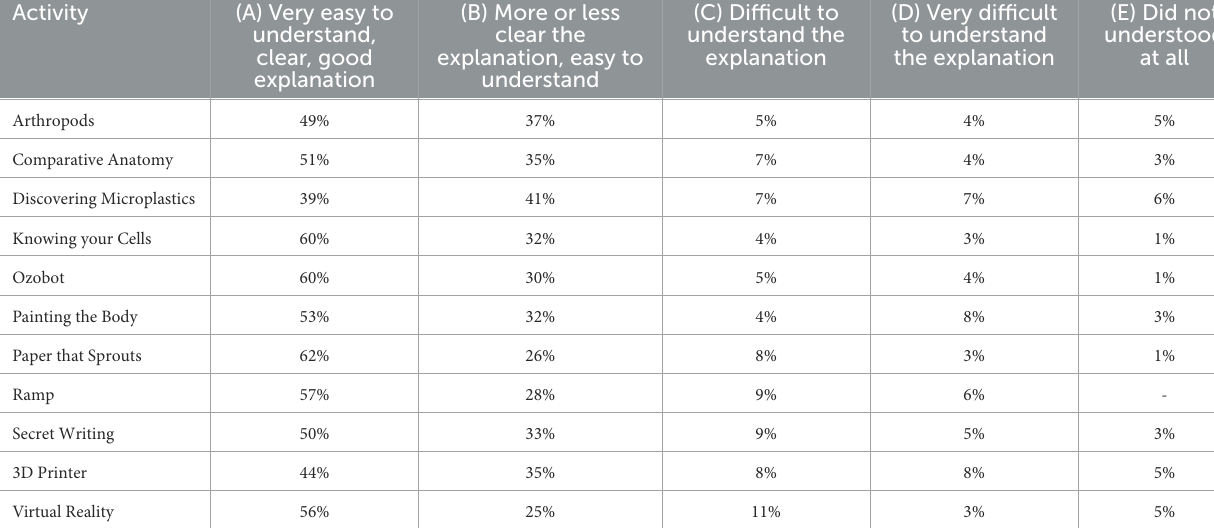
TABLE 1 Data in percentage about understanding the explanations in the video in BSL of each